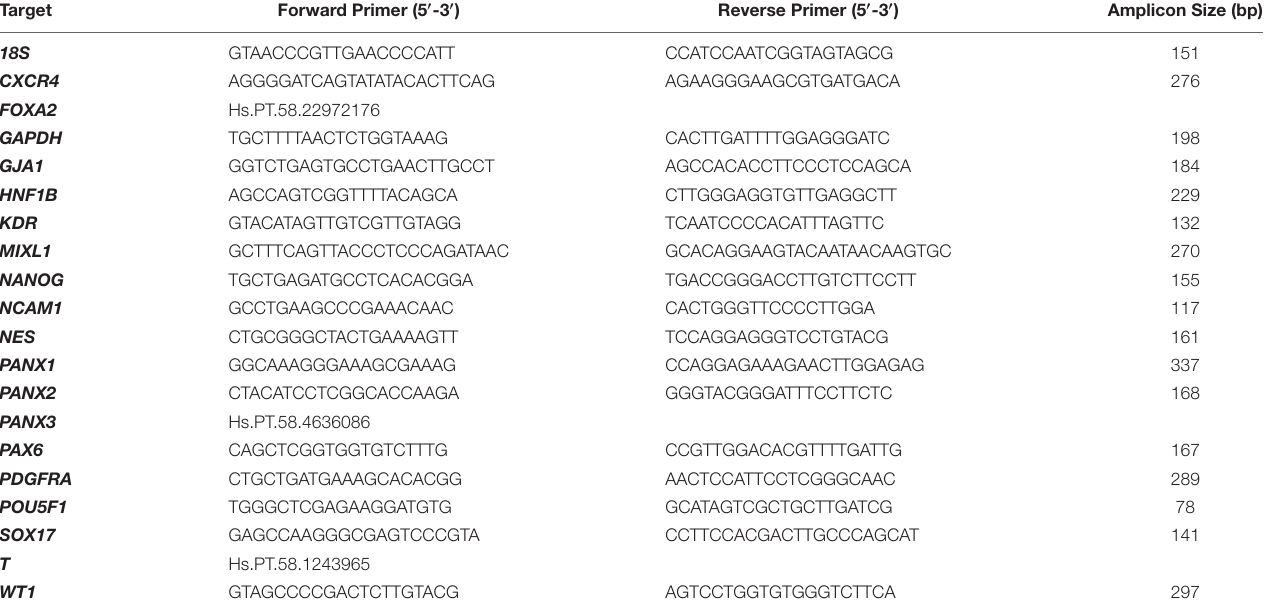
TABLE 1 | Oligo sets for qPCR. Target Forward Primer (5 (cid:48) -3 (cid:48) ) Reverse Primer (5 (cid:48) -3 (cid:48)